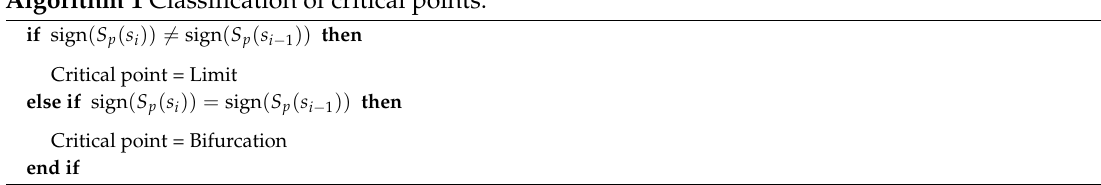
Algorithm 1 Classification of critical